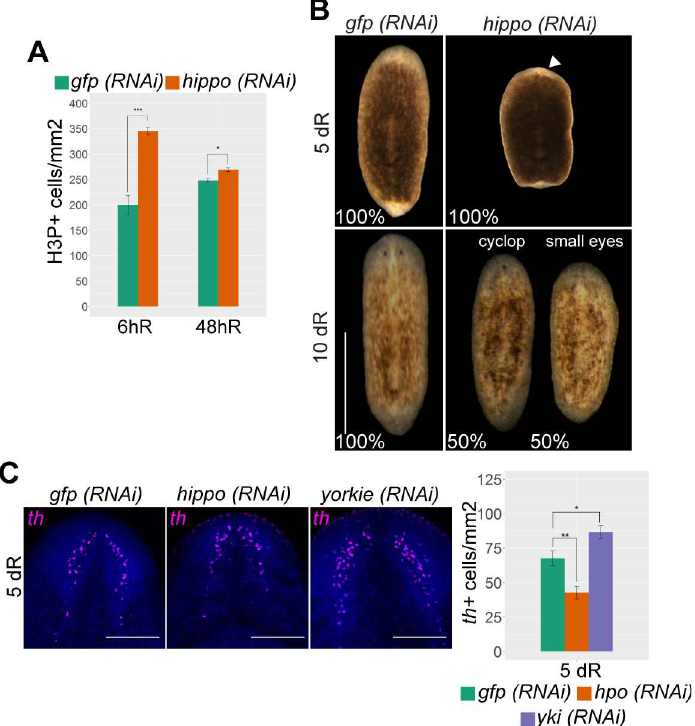
Fig 4. A hippo-yki signal is essential for proper planarian regeneration. (A) Quantification of H3P+ cells after 6 and 48 hRs in hippo (RNAi) animals and corresponding controls; n (cid:21) 8. (B) Stereomicroscopic view of live control and hippo (RNAi) animals after 5–10 dRs; n = 10. White arrow indicates the smaller blastema. (C) FISH for th + in control, hpo (RNAi) , and yki (RNAi) animals after 5 dRs. Nuclei are stained with DAPI. The corresponding quantification is shown ( n (cid:21) 5). The total number of th + cells was normalized with respect to the head area (from the anterior tip to the pharynx). Error bars represent standard deviation. Data were analyzed by Student t test. (cid:3) p < 0.05; (cid:3)(cid:3) p < 0.01. Data used in the generation of this figure can be found in S1 Data. Scale bars: 500 μ m (B); 150 μ m (C). dR, days of regeneration; FISH, fluorescent in situ hybridization; gfp , green fluorescent protein ; hpo , hippo ; hR, hours of regeneration; H3P, phospho-histone-H3-Ser10; RNAi, RNA interference; th +, tyrosine hydroxylase (dopaminergic neuron); yki , yorkie